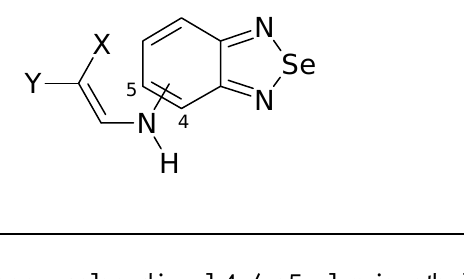
Table 1. 2,1,3-benzoselenadiazol-4-/or 5-ylaminoethylenes.